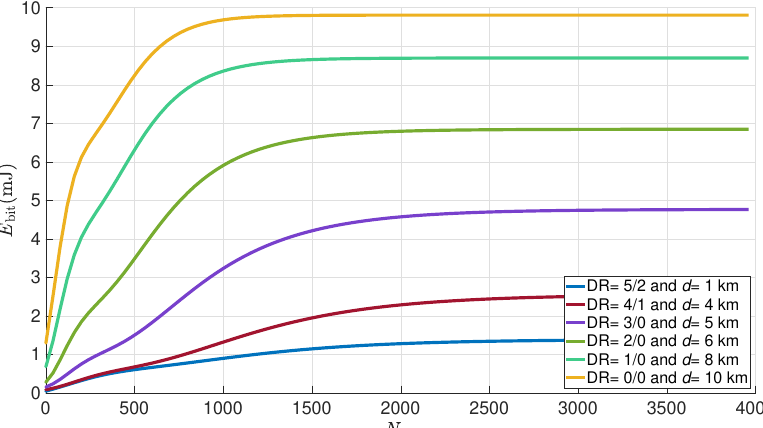
Figure 20. Average energy consumed per useful bit by a LoRa sensor for various distances vs. number of nodes in the network (FPayload = 50 bytes; NR = 8; P tx = 14 dBm; dc = 1%).